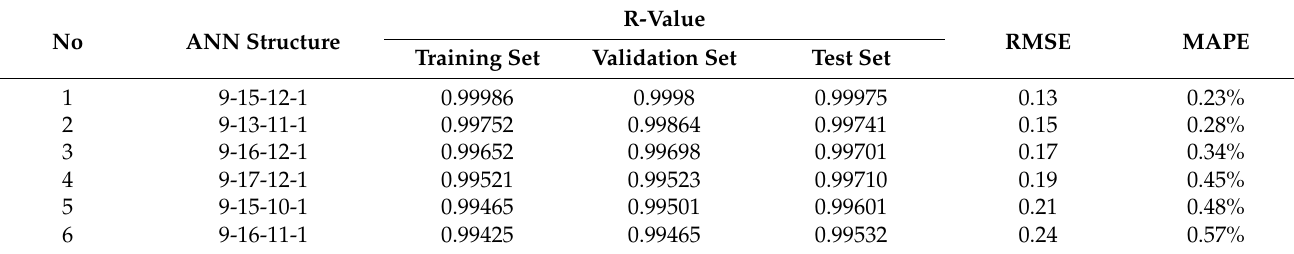
Table 5. The parameters of ANNs used for determining the hidden layer.